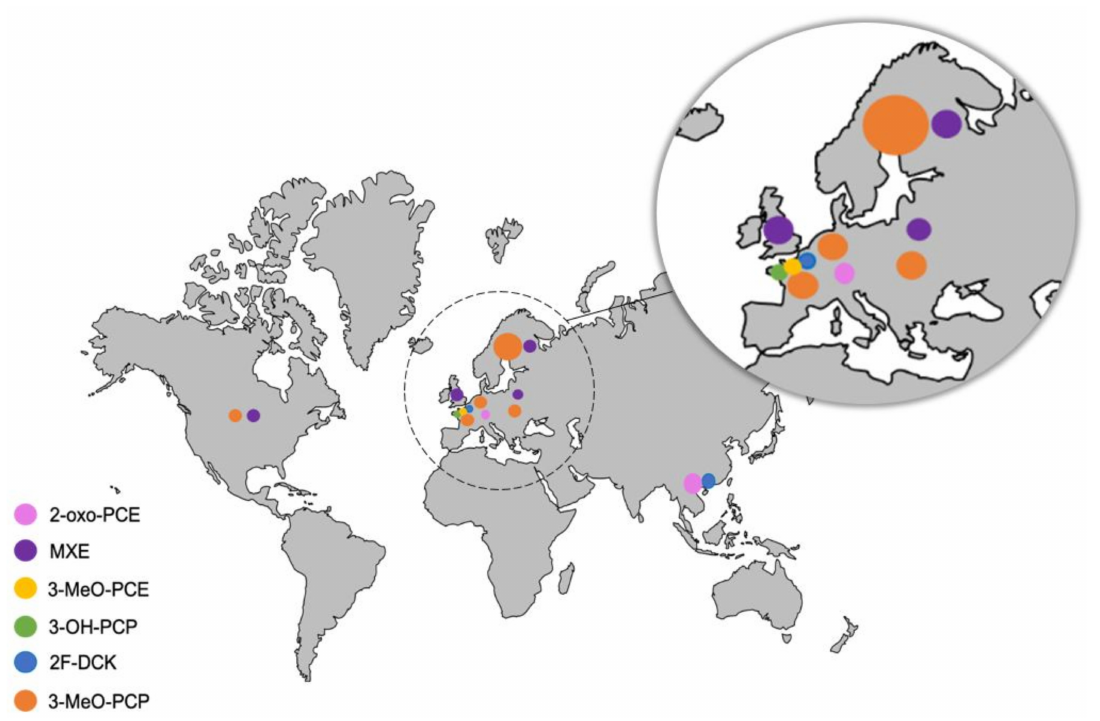
Figure 4. Geographical distribution of published cases of ACH-derivative